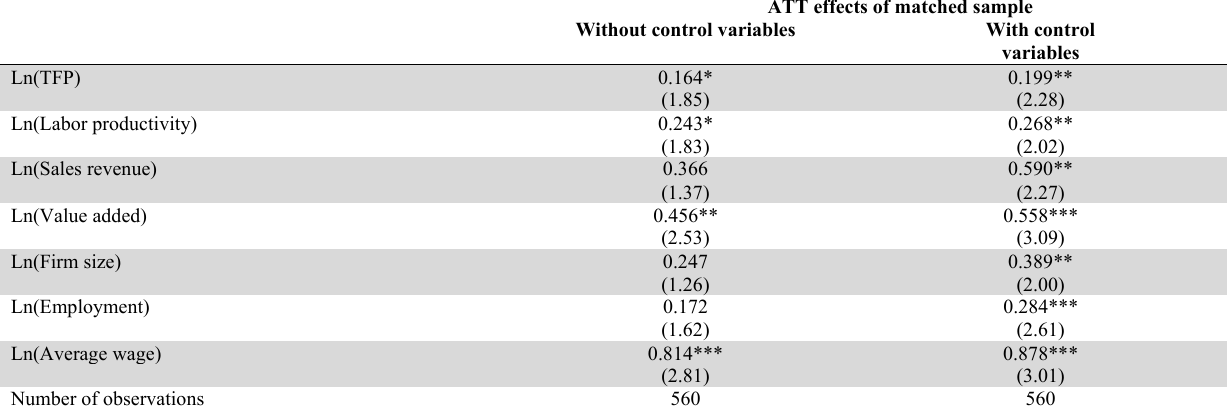
Effects of exporting on firm performance